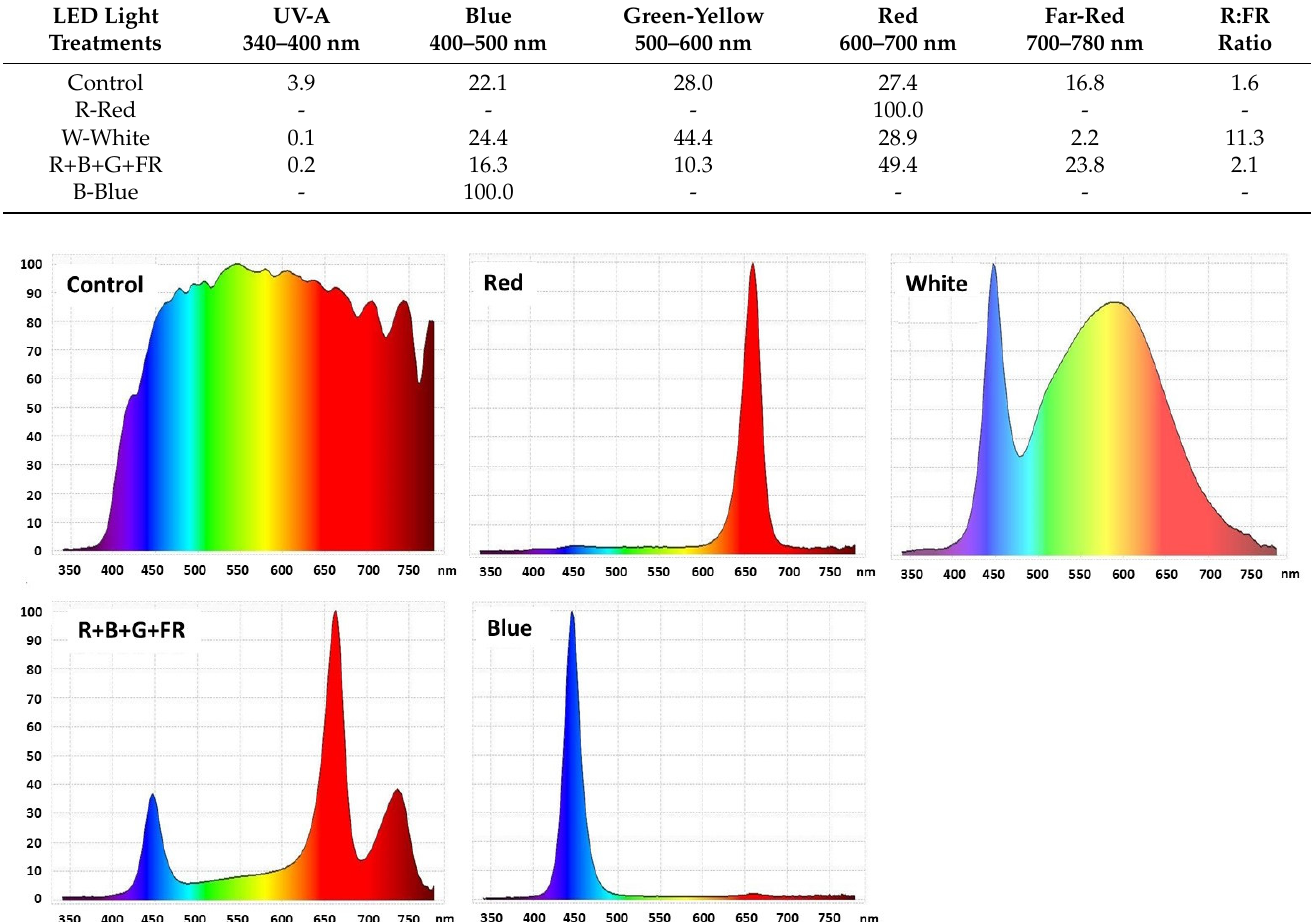
Figure 1. Spectral characteristics of lighting treatments: control—natural light inside the greenhouse in the winter, R—red, W—white, G—green, FR—far red, B—blue R+B+G+FR.